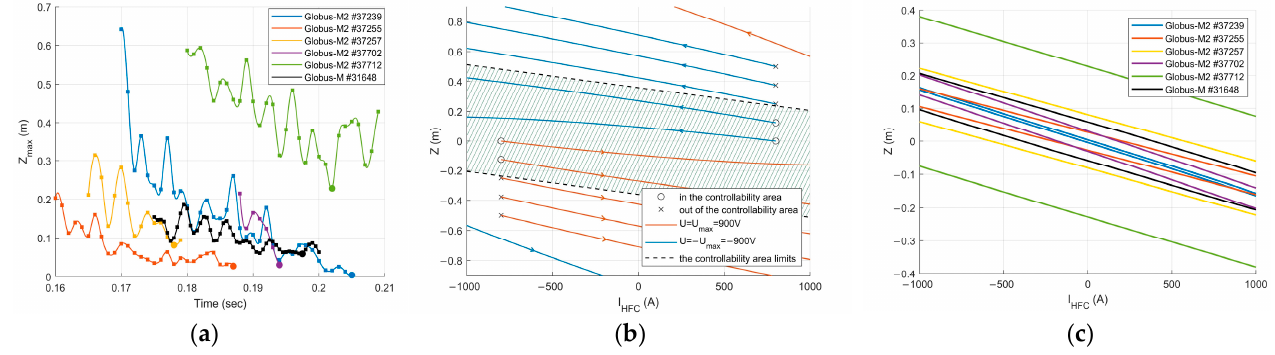
Figure 9. ( a ) Estimation of the vertical controllability area during the different shots of the Globus‑ M/M2 spherical tokamaks. Points correspond to the minimal vertical controllability area during the divertor phase of each shot. ( b ) The controllability area limits and phase trajectory projections on the plane ( I HFC , Z ) for the Globus‑M2 model at 197 ms of shot #37712 at a maximum of 900 V and a minimum of − 900 V on HFC. Circles denote points in the controllability area; x marks denote points out of the controllability area; green shading corresponds to the controllability area (18). ( c ) Minimal controllability area during shots on the plane ( I HFC , Z ).